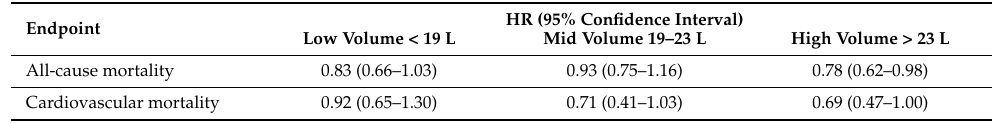
Table 2. Hazard ratio (HR) for mortality outcomes by delivered convection volume per session for online HDF compared to standard HD